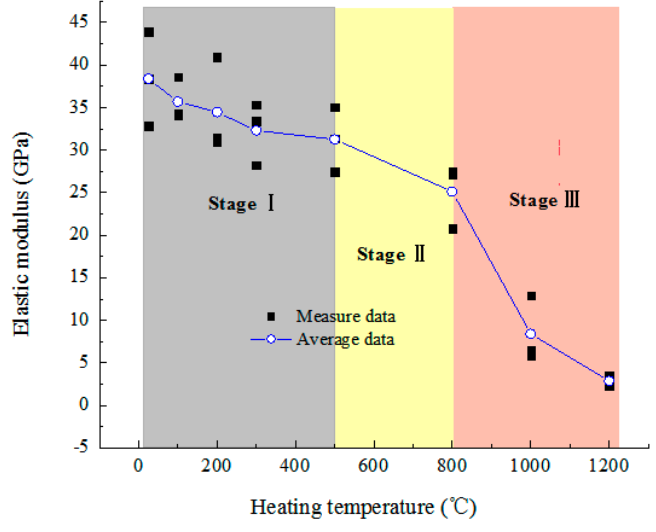
Figure 14. Variation of elastic modulus of the granite samples with heating temperature.